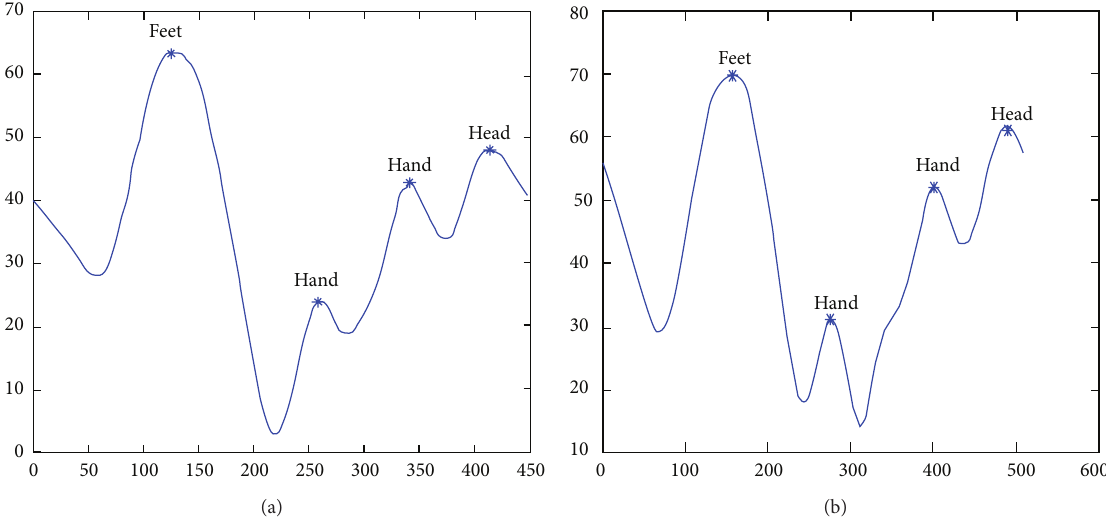
Figure 4: The distance curves of the two images in Figure 3, the local maximum points on the curves, and their corresponding significant body points.